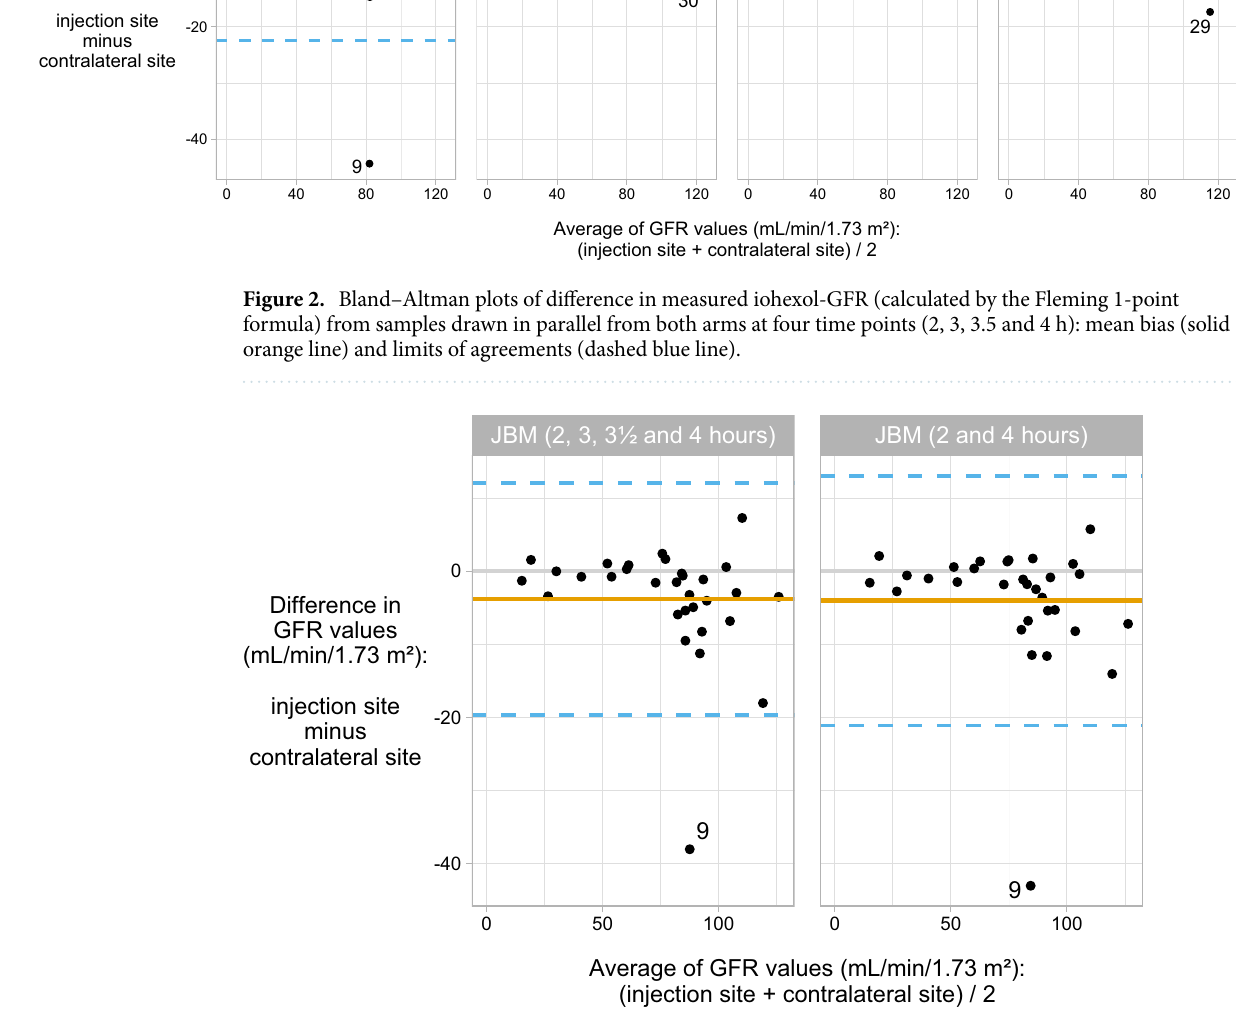
Figure 3. Bland–Altman plots of difference in measured iohexol-GFR (calculated by the JBM 2-point and 4-point formula) from samples drawn in parallel from both arms: mean bias (solid orange line) and limits of agreements (dashed blue line).